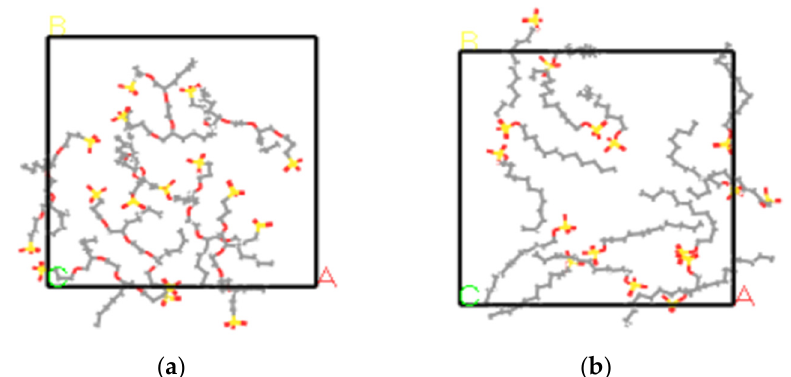
Figure 4. ( a ) S2; ( b ) SDS top view of final adsorption configurations.